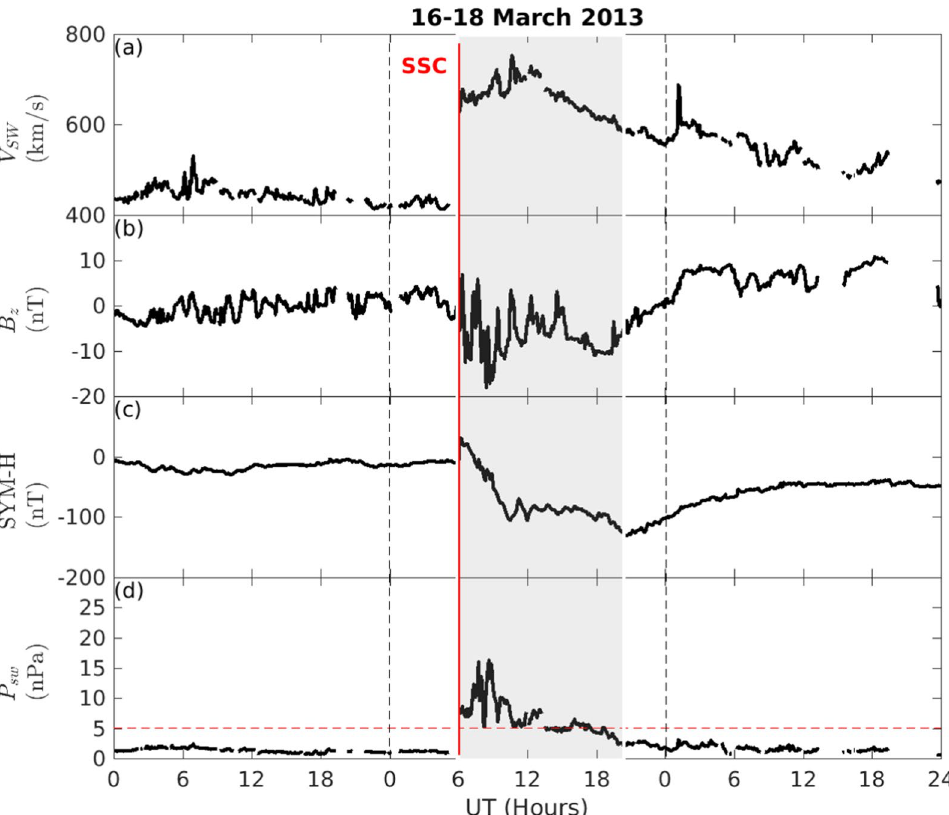
Fig. 1 Solar wind parameters for a strong geomagnetic storm that occurred between 16 and 18 March 2013. Panels present variations of ( a ) solar wind speed, V SW (km/s), ( b ) z component of interplanetary magnetic field, IMF Bz (nT), ( c ) SYM-H (nT) and ( d ) solar wind pressure, P sw (nPa) with time. The grey shaded region represents the main phase of the geomagnetic storm. The dotted red line represents the threshold value for P sw